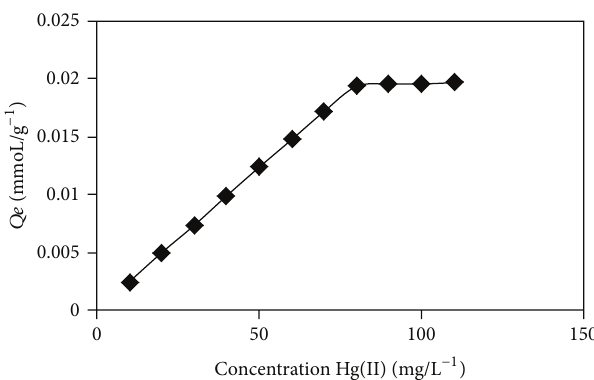
Figure 4: Adsorption profile of Hg(II) as a function of increasing metal concentration. Conditions: [Hg 2+ ]: 10–160 𝜇 gmL −1 , volume: 50 mL, pH: 4, and m(5Ph8HQ):